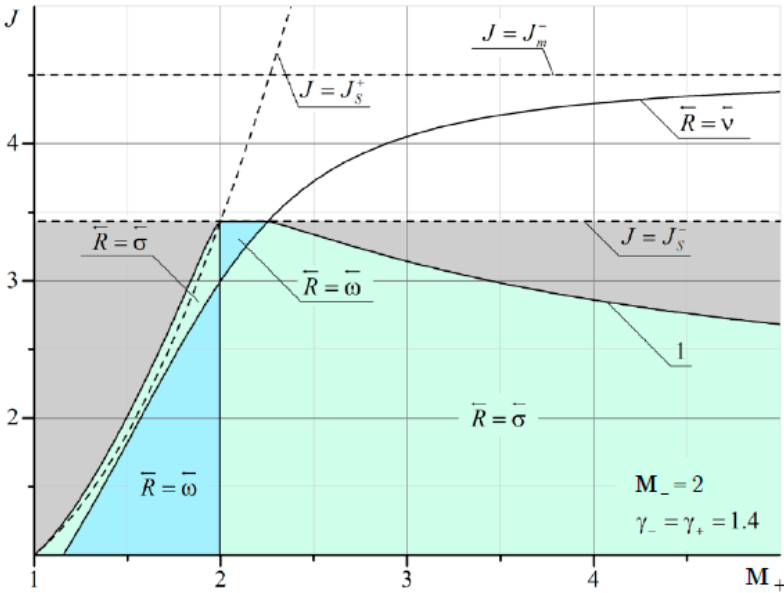
Figure A7. Domains of existence of reflected discontinuities for refraction in a flow of diatomic gas. The Mach number of the flow from which the shock comes is M – = 2. The domains of existence of reflected discontinuities for refraction in a flow of diatomic gas at the Mach number of the flow M – = 3 are shown in Figure